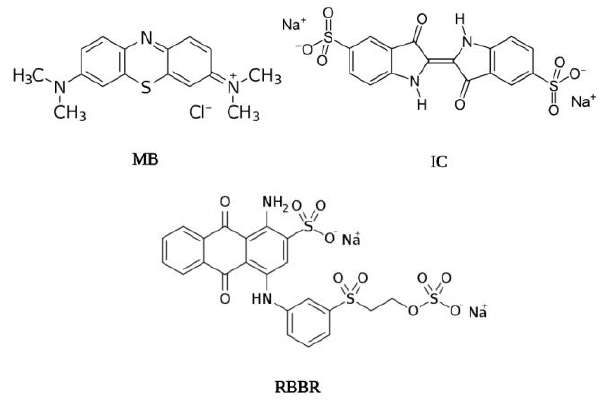
Figure 2. Chemical structure of synthetic dyes MB, RBBR and IС.